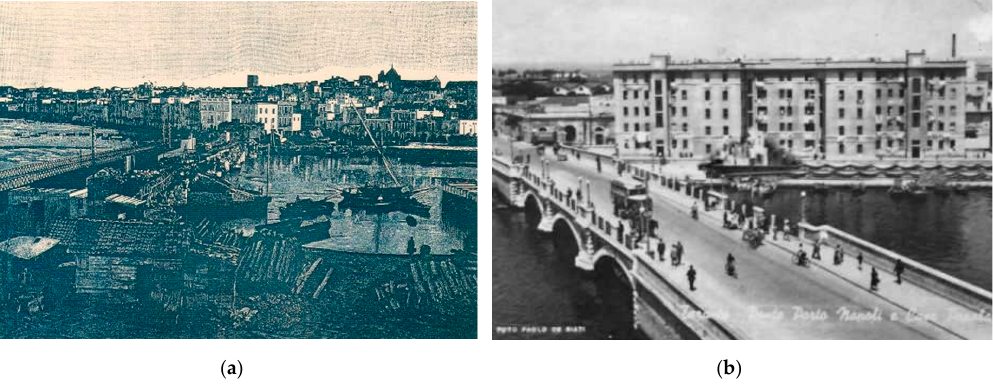
Figure 5. Historical images: ( a ) the western entrance of the city of Taranto following the flood of 1883; ( b ) the Porta Napoli bridge in a photograph from the beginning of the 20th century.